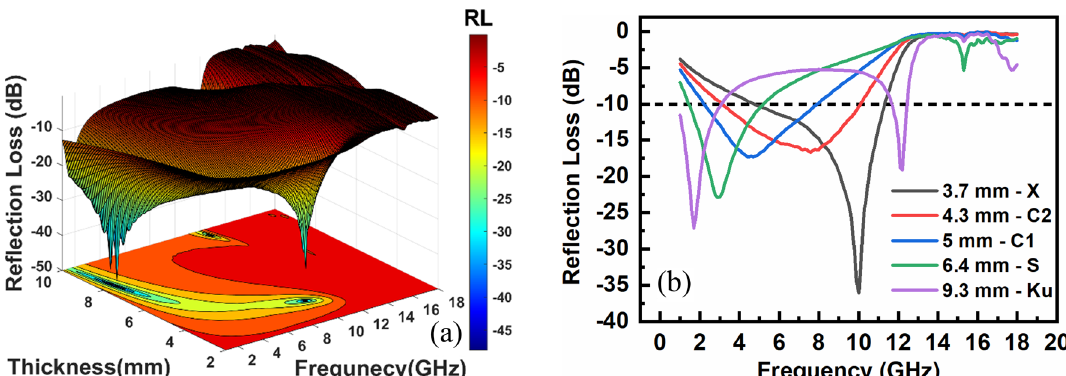
Figure 9. ( a ) Reflection loss (RL) plots showing the distribution of RL versus thickness and frequency and ( b ) RL plots for the optimum thickness in various